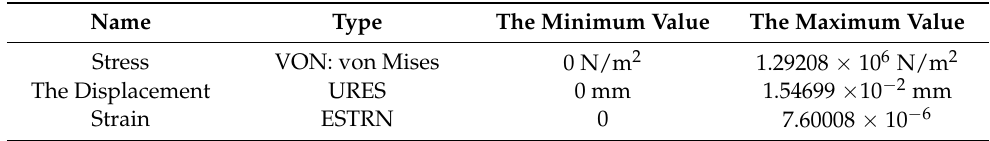
Table 3. Head structure statics solution parameter table.